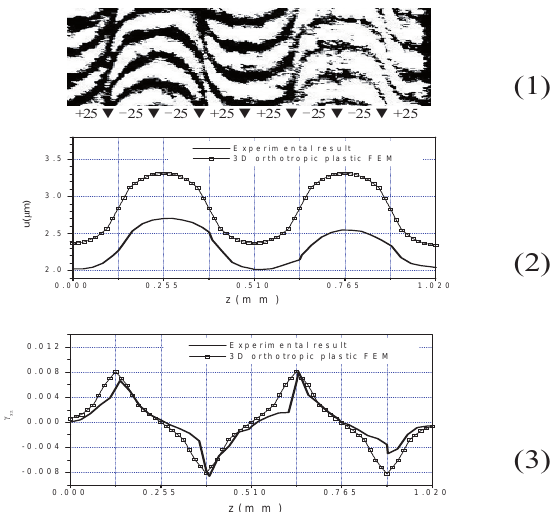
Fig. 6 Interlaminar deformations of [±25] s4 laminate loaded at 882N (1) U Fringe Patterns, (cid:4) Actual Ply Boundaries (2) experimental vs numerical interlaminar displacement u (3) experimental vs numerical interlaminar shear strain (cid:2)